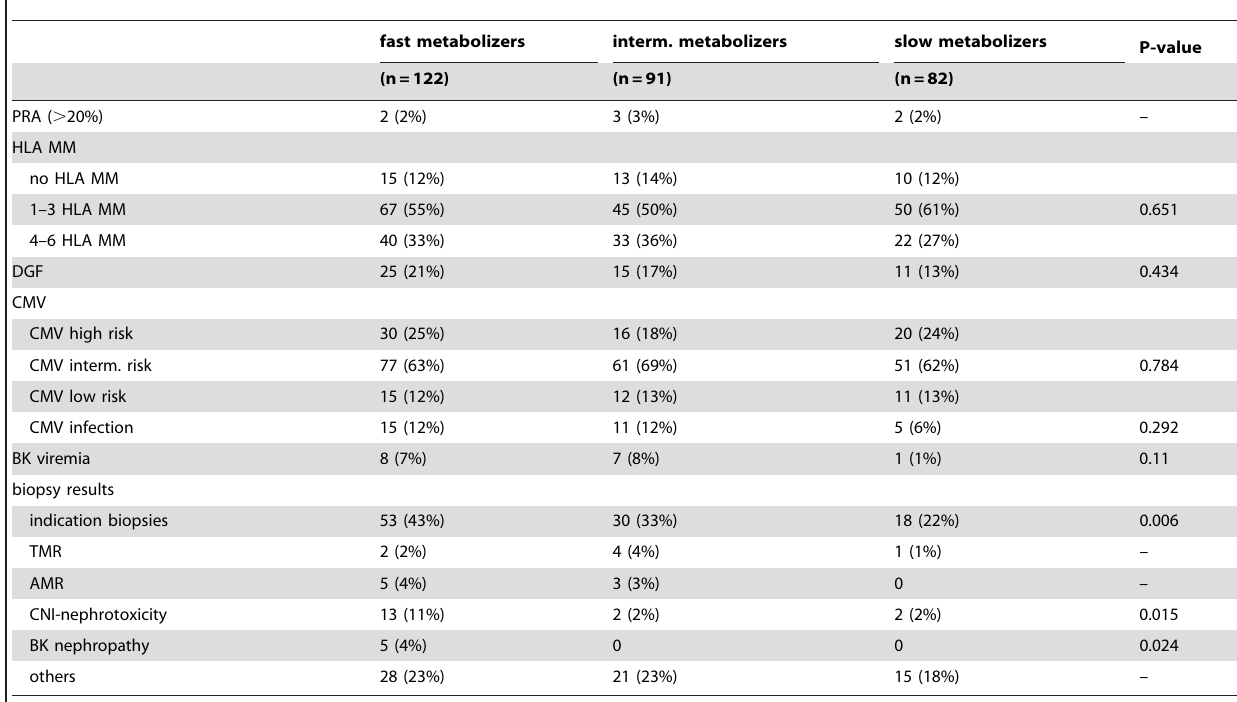
Table 4. Antibodies, HLA MM, DGF, infections and biopsy results.